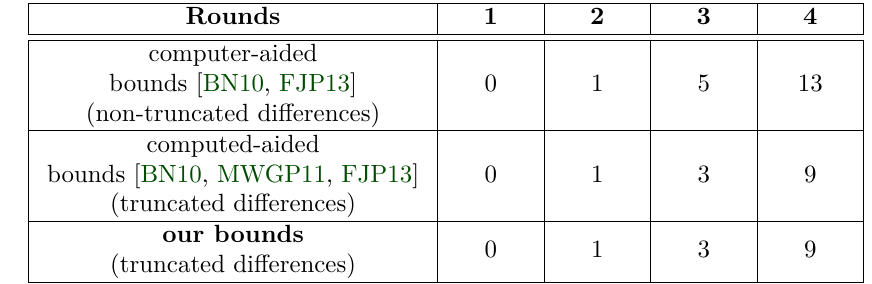
Table 1: Summary of the proven bounds on the number of active Sboxes in a related-key differential path for several rounds of AES-128 . While previous works used computer-aided search, we obtained our bounds without any computation help.